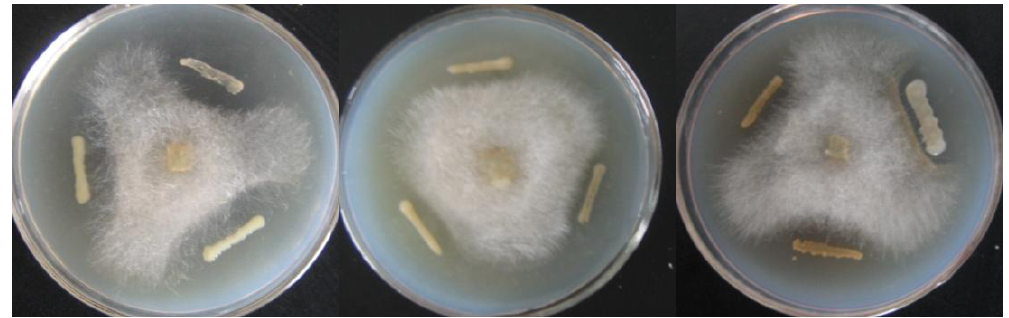
Figure 1. Screening of antagonistic bacteria used plate confrontation method in PDA (Potato Dextrose Agar) plates. In the middle of the agar plates are the Phytophthora nicotianae, around the Phytophthora nicotianae are parts of the antagonistic